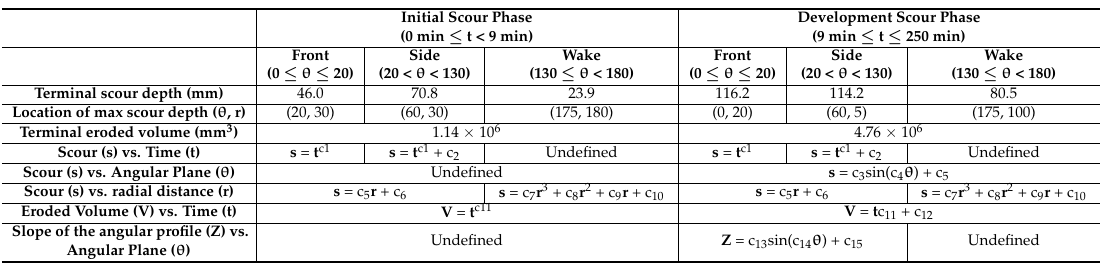
Table 1. Quantitative characteristics of the various phases and regions. Parameters c i are constants used in the derived equations.